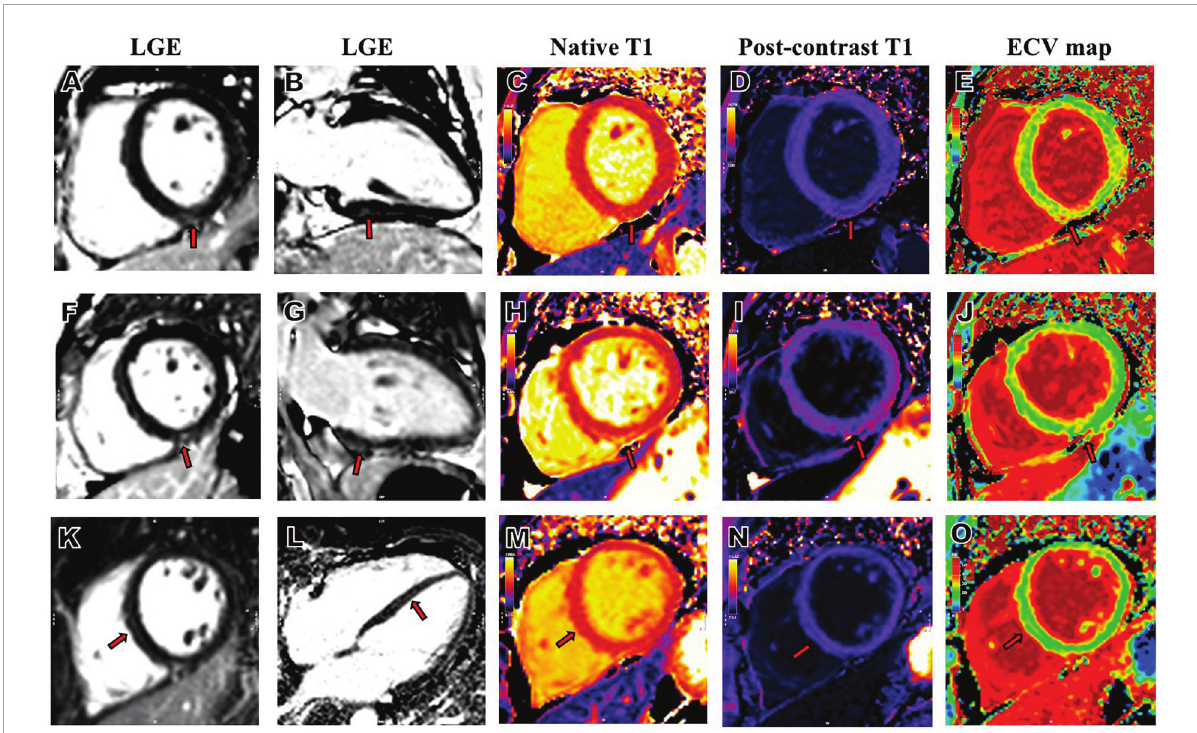
FIGURE2 Representative LGE, native T1, post-contrast T1and ECV map images from patients who had COVID-19. A 34-year-old female patient with severe COVID-19, whose RV insertion point showed positive LGE in short axis (A) , 2-chamber long-axis (B) , increased native T1 (C) , decreased post-contrast T1 (D) and increased ECV (E) . A 50-year-old female patient with severe COVID-19, whose inferior mid-wall showed positive LGE in short axis (F) , 2-chamber long-axis (G) , increased native T1 (H) , decreased post-contrast T1 (I) and increased ECV (J) . A 46-year-old male patient with severe COVID-19, whose septal mid-wall showed positive LGE in short axis (K) , 4-chamber long-axis (L) , increased native T1 (M) , decreased post-contrast T1 (N) and increased ECV (O) . COVID-19, coronavirus disease 2019; LGE, late gadolinium enhancement; ECV, extracellular volume; RV, right